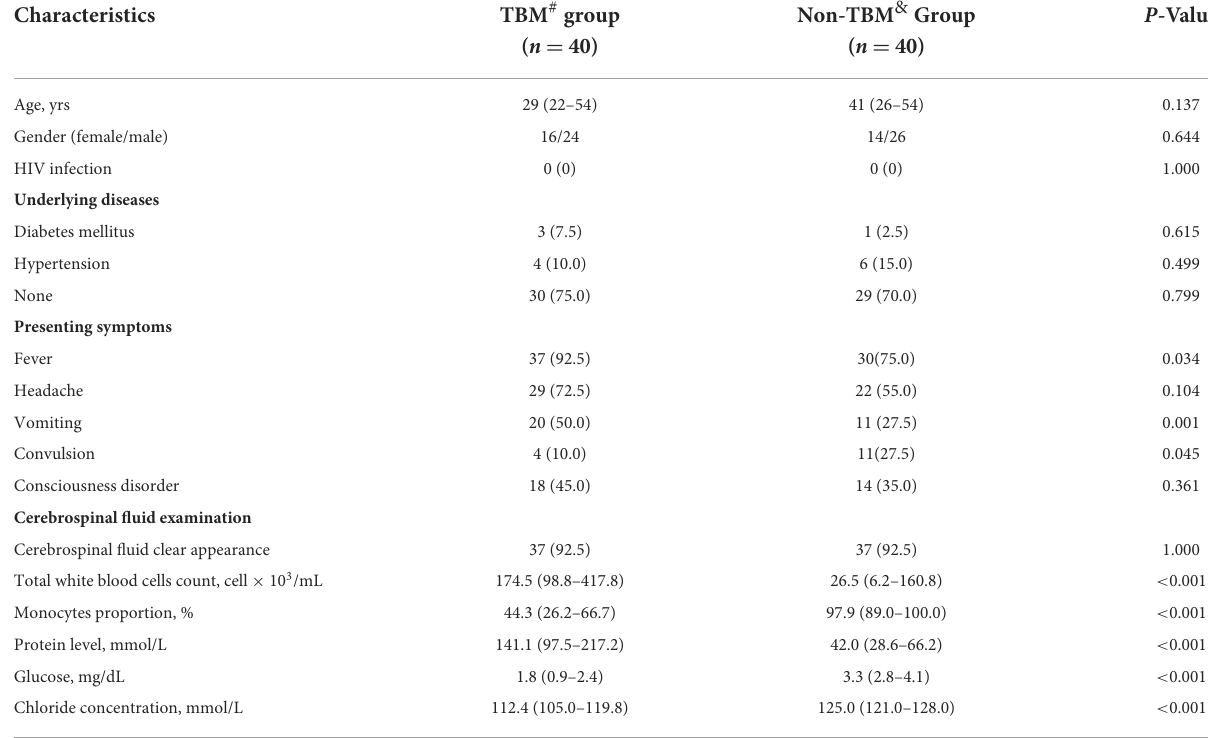
TABLE 1 Demographic and baseline clinical characteristics of participants *